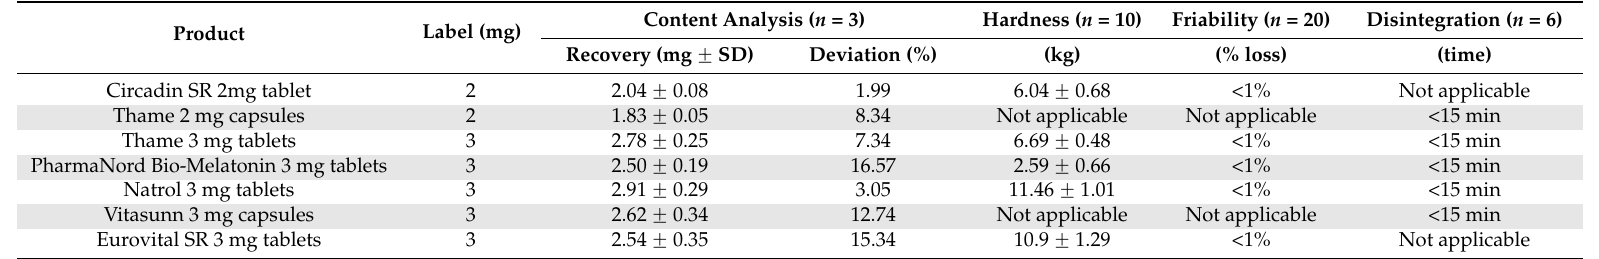
Table 4. Other quality parameters evaluated for all melatonin